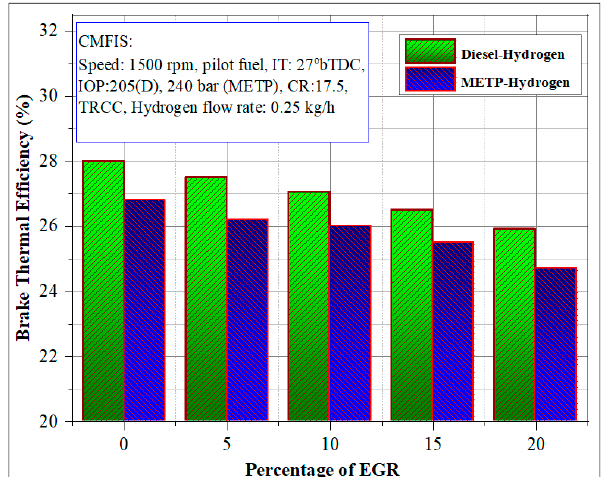
Figure 5. Effect of Exhaust Gas Recirculation (EGR) on the Brake Thermal Efficiency (BTE) with Figure 5. E ff ect of Exhaust Gas Recirculation (EGR) on the Brake Thermal E ffi ciency (BTE) with induction method. induction